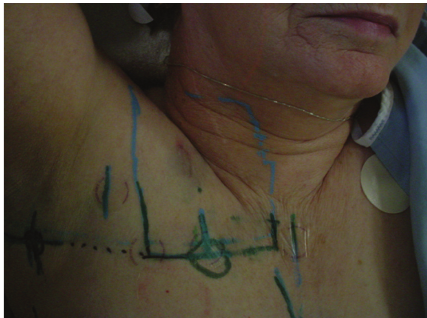
Figure 4: Supraclavicular light field with central scar from tumor